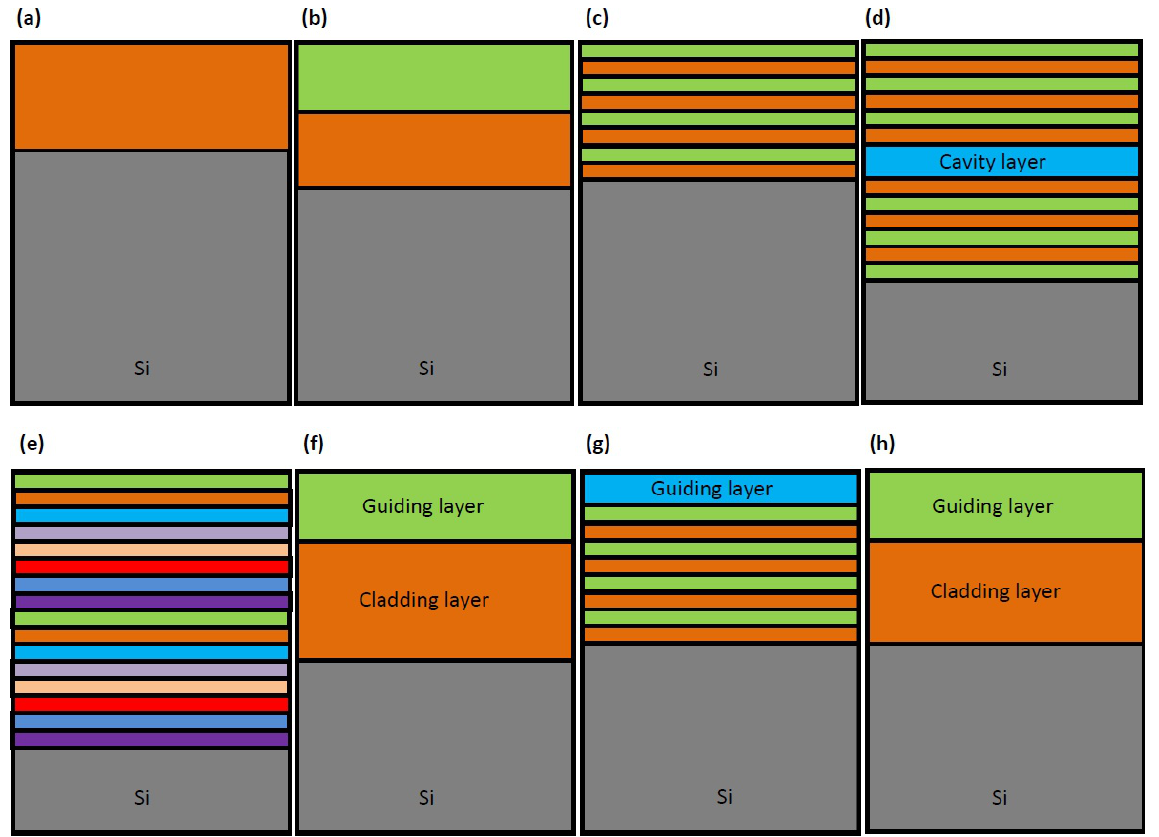
Fig. 5. Schematics of the various PSi optical structures: (a) single layer, (b) double layer, (c) Bragg reflec- tor, (d) microcavity, (e) rugate filter, (f) waveguide, (g) Bloch surface wave, and (h) ring